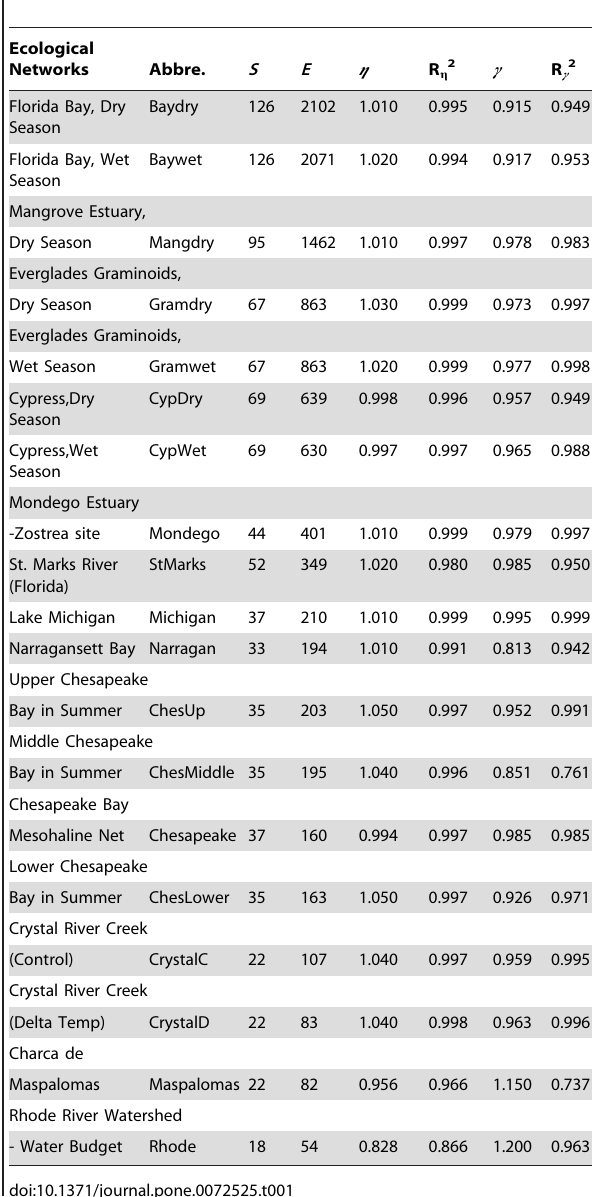
Table 1. Empirical Ecological Flow Networks and Their Scaling Exponents.